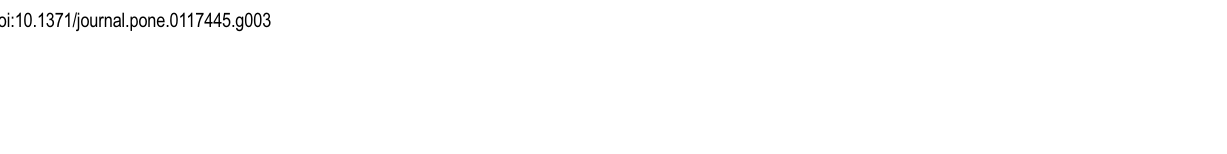
PLOS ONE | DOI:10.1371/journal.pone.0117445 February 2,